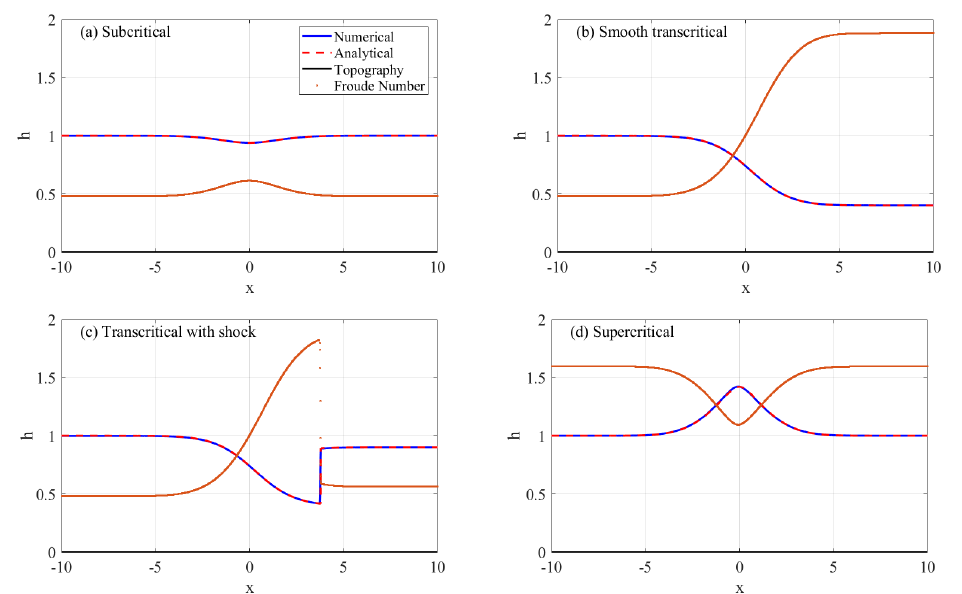
Figure 6. Various steady flows in a rectangular channel with a contraction for − 10 ≤ x ≤ 10, for cases ( a ) subcritical, ( b ) smooth transcritical, ( c ) transcritical with shock, ( d )